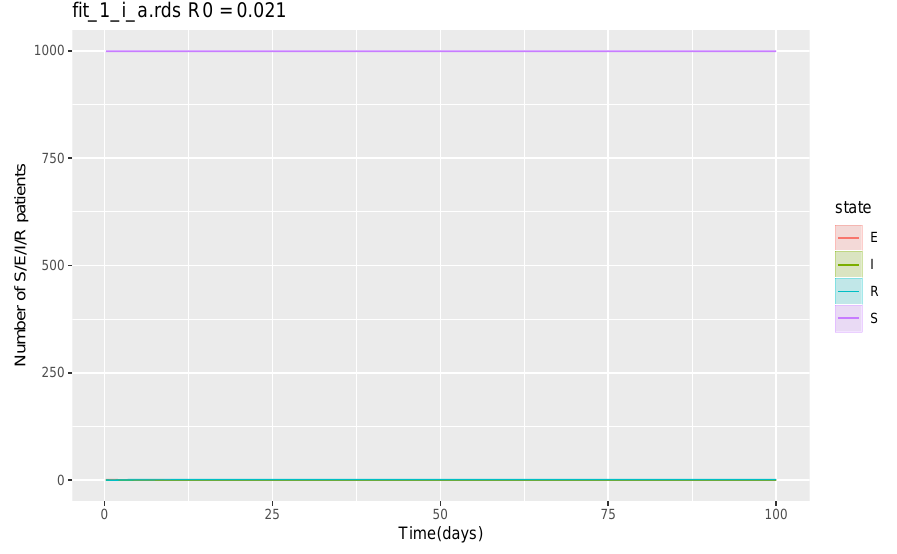
Figure 2. SEIR model with the best-case scenario. Abbreviations S = susceptible, E = exposed, I = infected, and R = recovered and